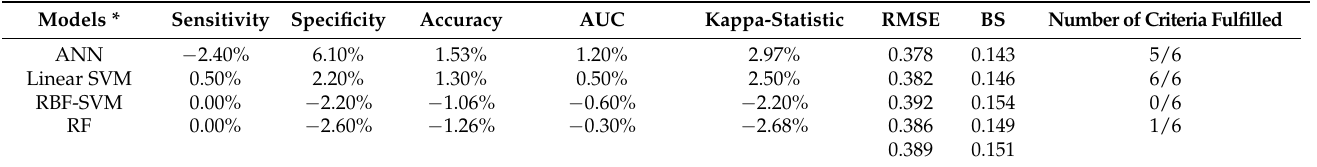
Table 3. Percentage change in performance matrices of ML-based RPMs to conventional baseline RPM. Models * Sensitivity Specificity Accuracy AUC Kappa-Statistic RMSE